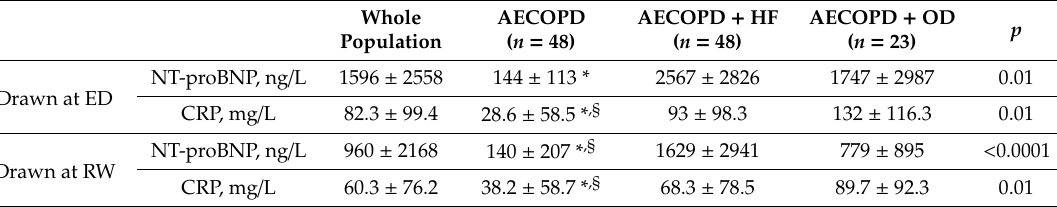
Table 3. NT-proBNP and CRP values at ED and RW in the whole population and in the three RW diagnostic